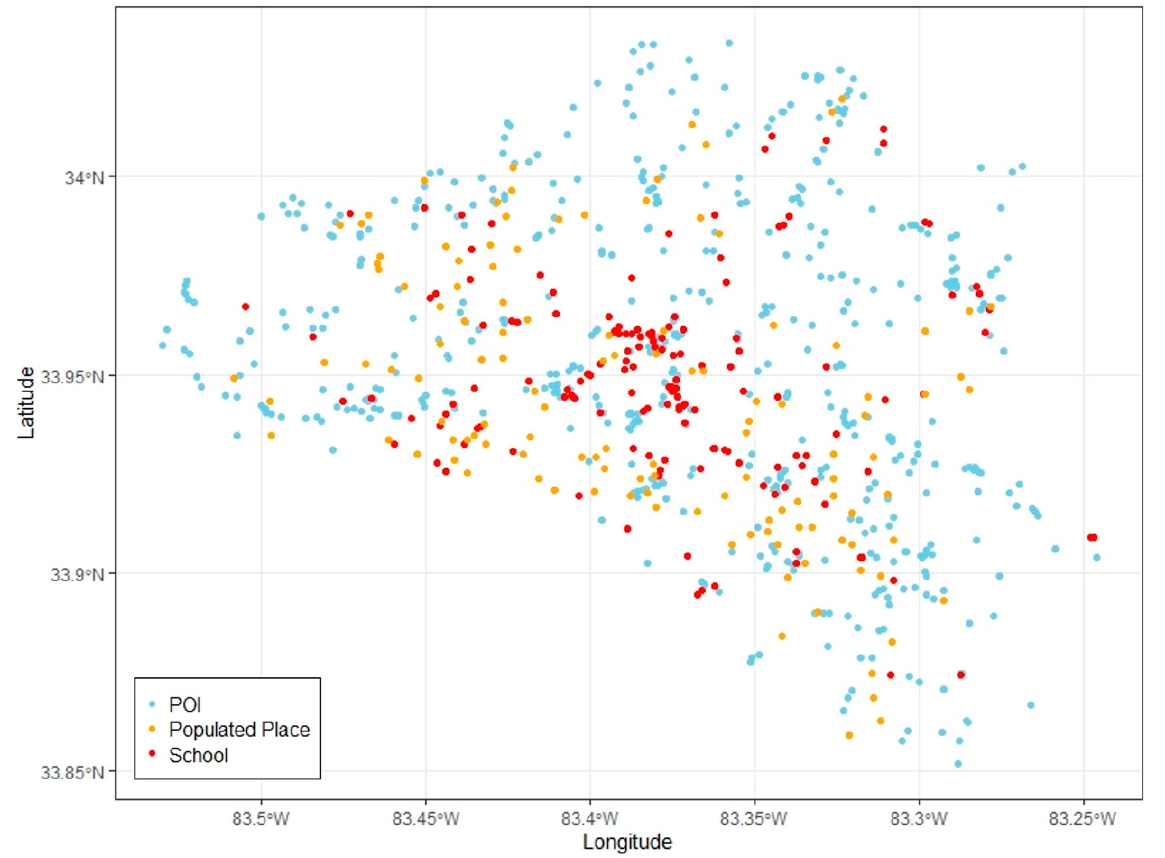
Figure 7. Distribution of POI, Populated Place, and School locations in Athens, GA.